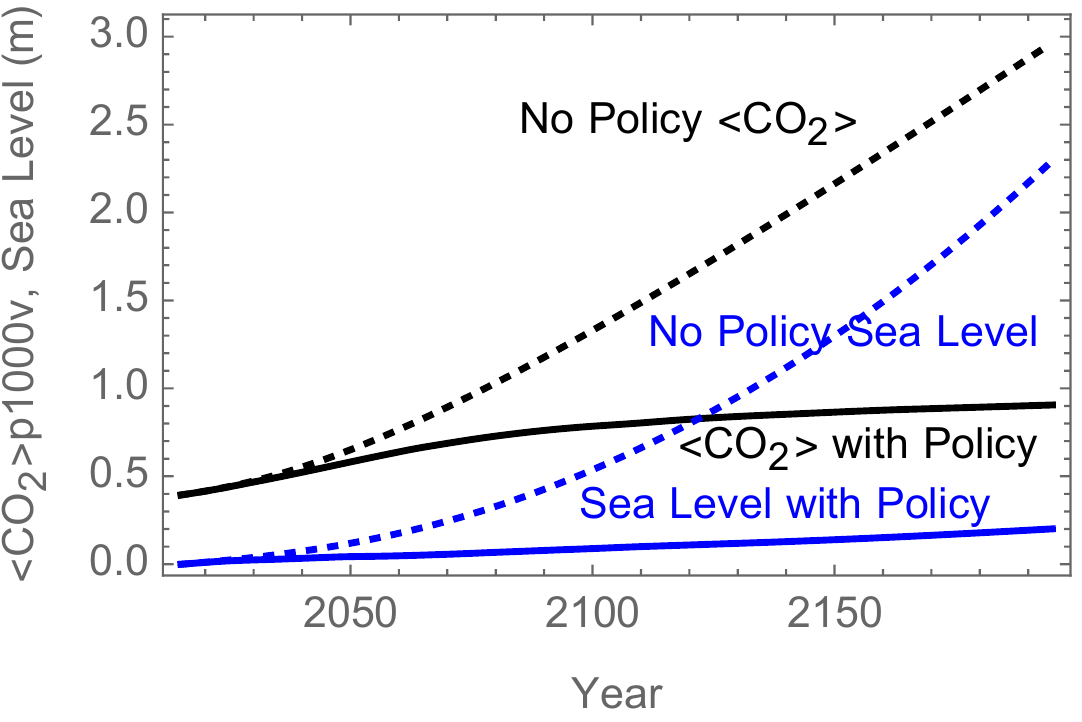
Figure 2. Atmospheric CO concentrations in parts per thousand by volume, and increase of 2 sea level over its 2015 value, with (solid curves) and without (dashed curves) participants’ policy